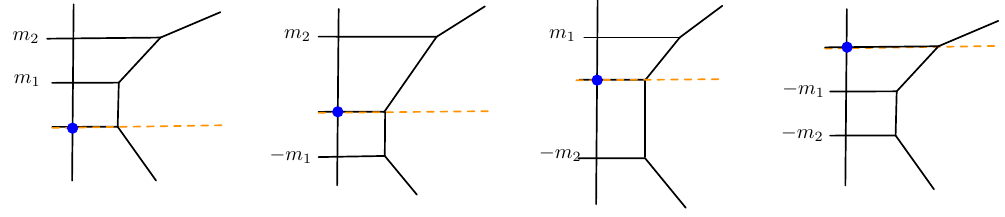
Figure 12 . In this figure, brane webs for the theory U(1) level k eff = 1